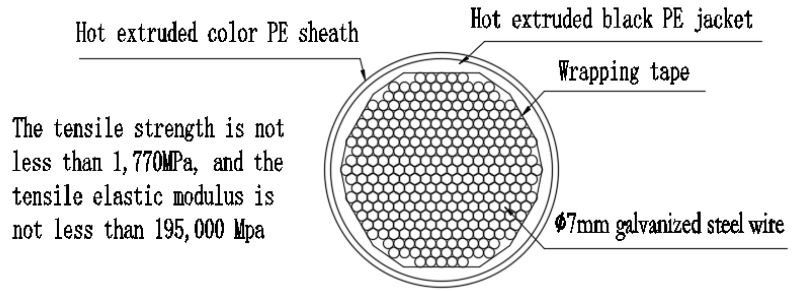
Figure 4. Cross-sectional view of the cable.